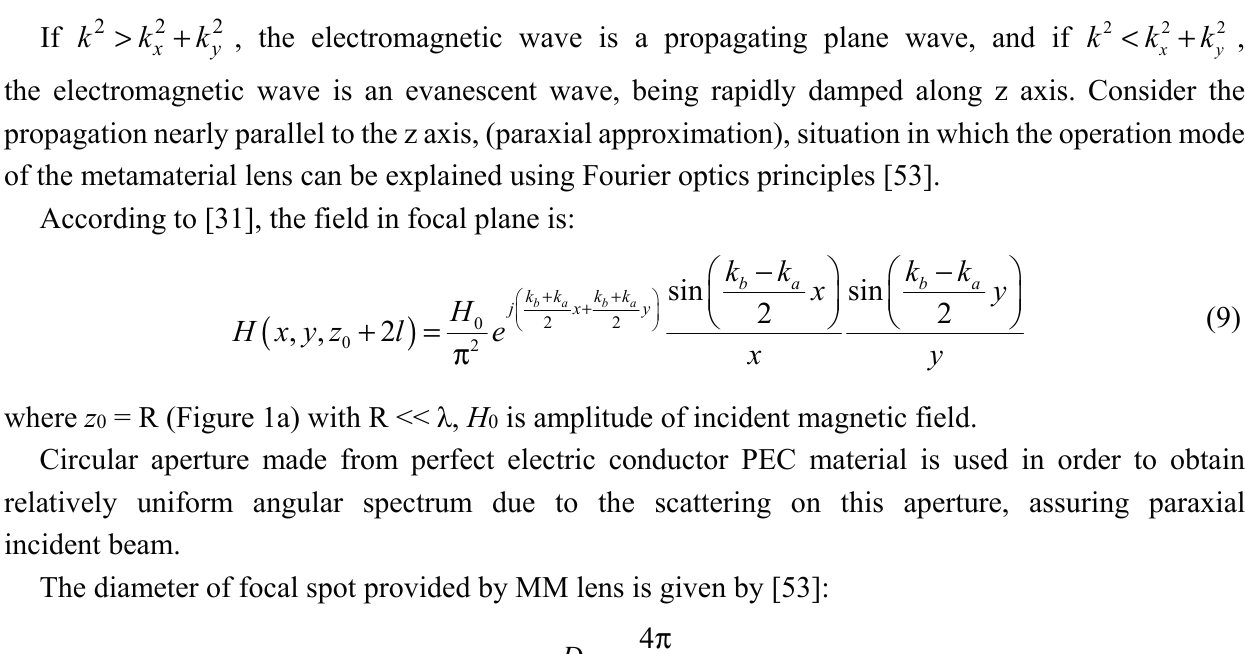
Figure 2. The frequency dependence of effective permeability of conical Swiss